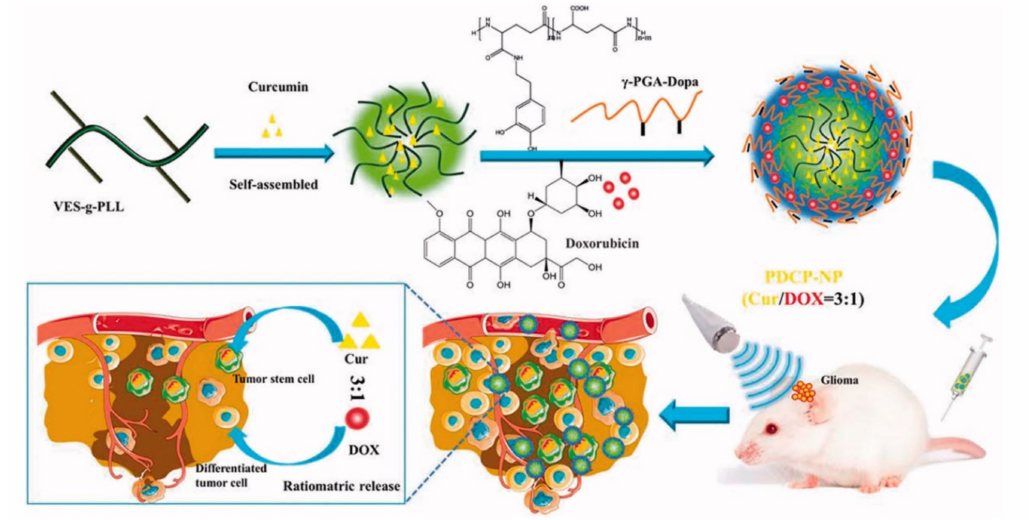
Figure 3. Schematic diagram of pH-sensitive core–shell nanoparticles for ratiometric drug release. The curcumin / doxorubicin co-loaded on the pH-sensitive core–shell nanoparticles is released at a constant ratio in cancer cells. Reproduced with permission from [28], Drug delivery,